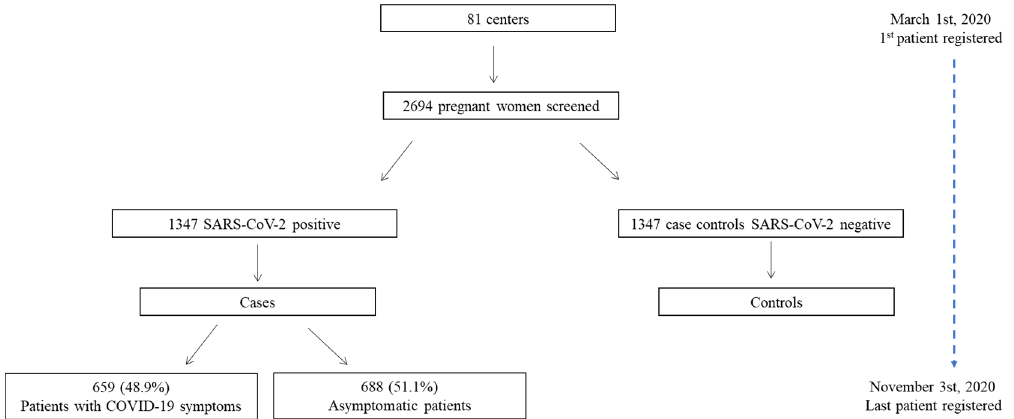
Figure 1. Flowchart showing the enrollment of cases and controls in our multicenter study and proportions of cases showing symptoms during the study period.